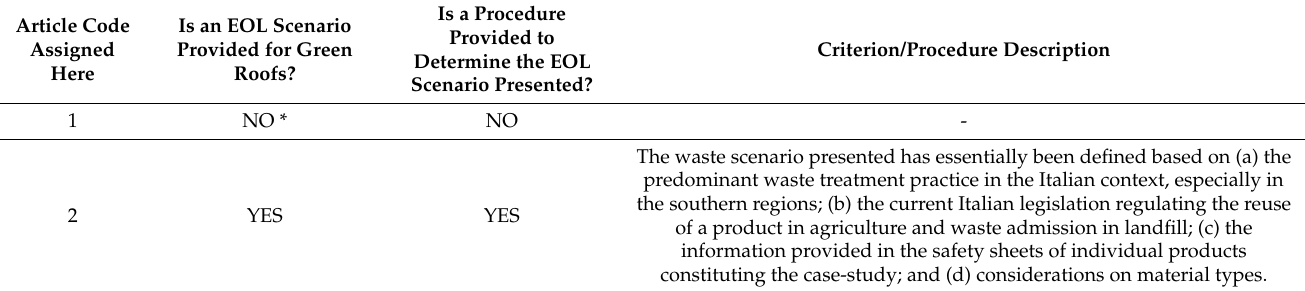
Table 6. Comparison among the eleven LCA and LCC studies with respect to the delivery of criteria and/or procedures to define the presented EoL scenarios of green roofs ND = not declared in the